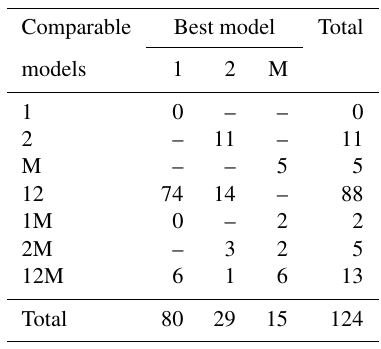
Table 6. Shows the best and acceptable models for the 124 individ- ual forest plots for mass. Models are labelled as “M” for MST, “1” for the one-parameter DET-LTWD and “2” for the two-parameter DET-LTWD. Columns refer to the best-fitting model (lowest BIC score). Rows refer to models that are so good a fit compared to the best that they cannot be rejected, as their BIC score is so close to the best model. For example “1M” means the MST and one-parameter models are not rejected but the two-parameter model is rejected based on BIC. Then the columns in this row show how many forest plots have either the 1 or M model as the best